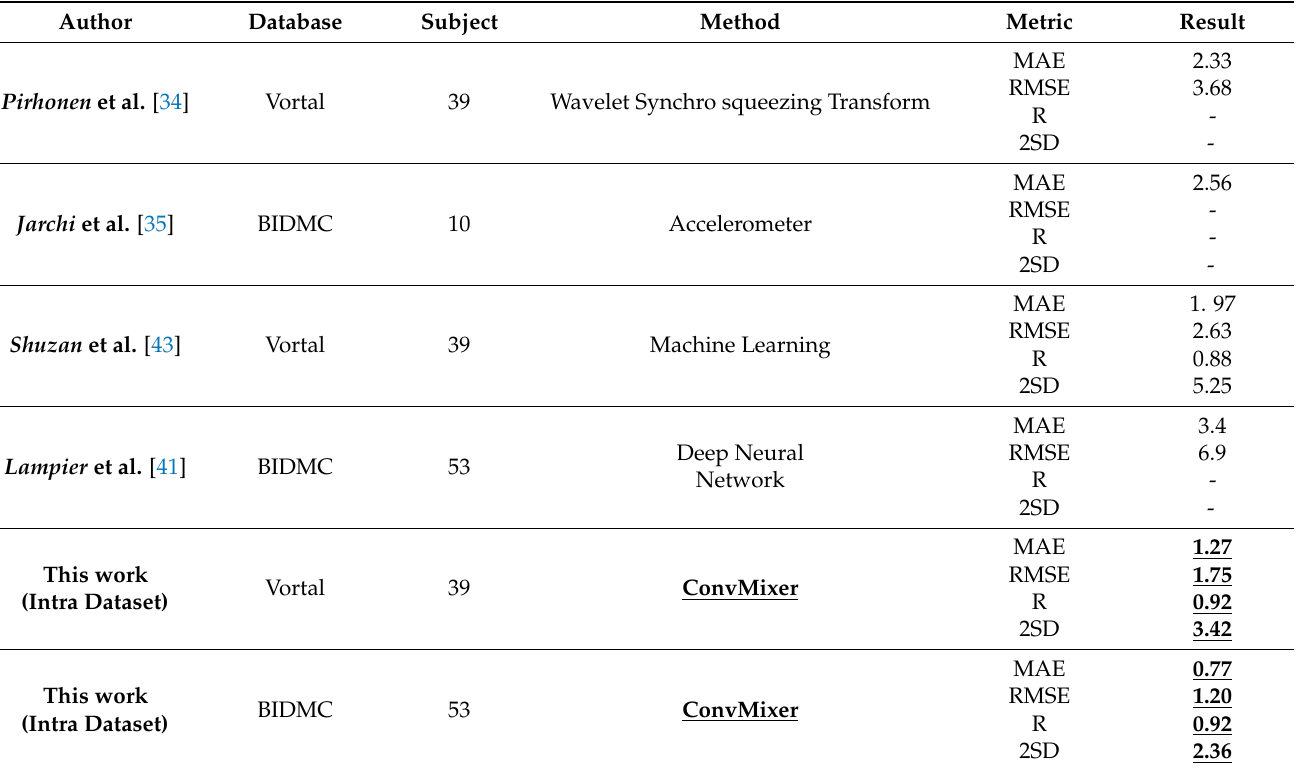
Table 4. Summary of recent related works with this work, including the database, methodology, and estimation error for RR. MAE, RMSE, and 2SD are in